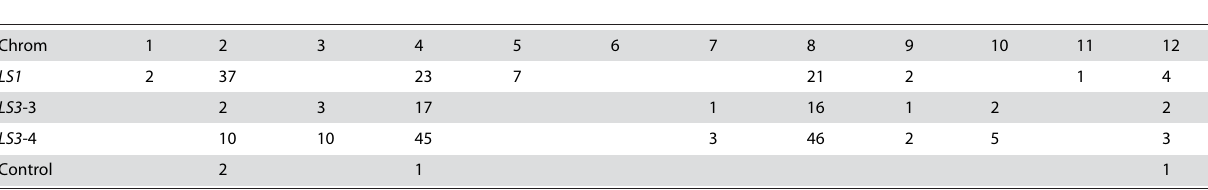
Note: When a match is counted, the homology between the insertion sequence and tomato genomic sequence usually ranged between 66–88% identity. See Figure 3 for sequence that matches the tomato genomic